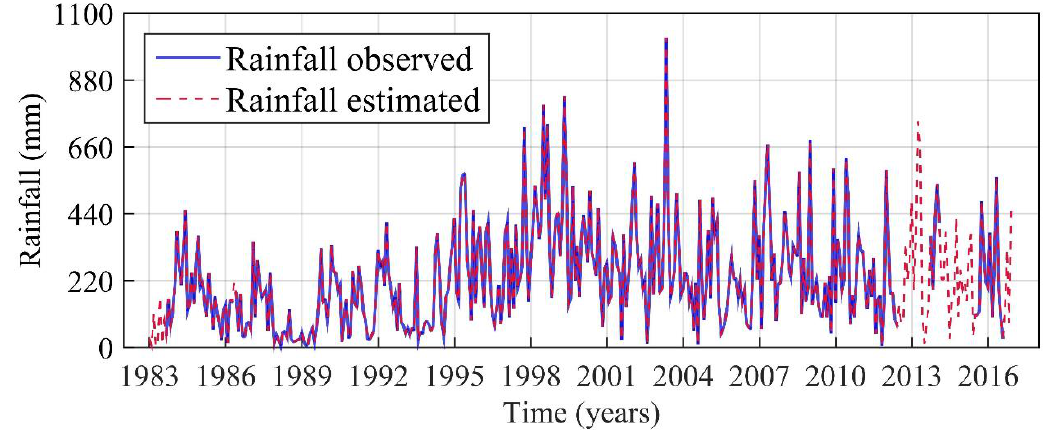
Figure 3. Time series rainfall of Remolino (REM) gauge station: observed vs. estimated.